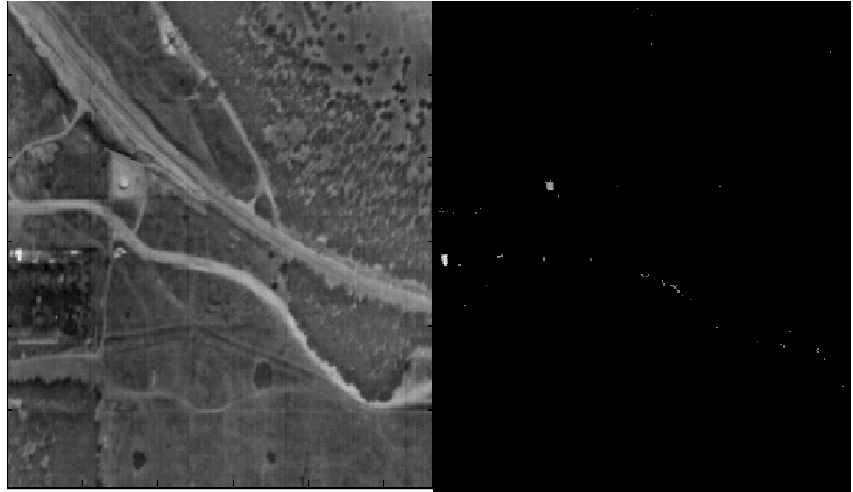
Figure 17. Left: The scene from Figure 5. Right: Points that contain a target in a sub-pixel when t > 0 . 5